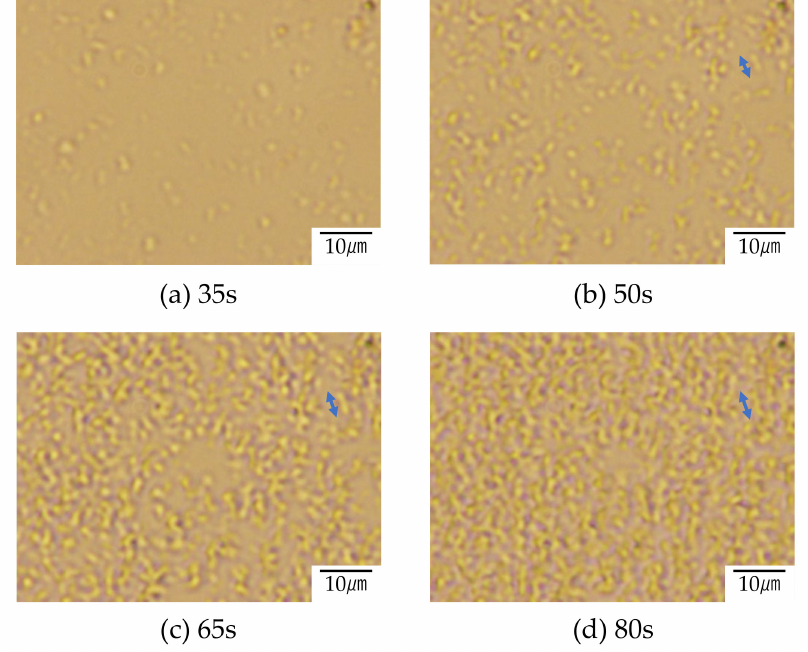
Figure 8. Structure development of 60 / 40 PTT / PET during the crystallization at 210 ◦ C after ( a ) 35 s, ( b ) 50 s, ( c ) 65 s and ( d ) 80 s observed by optical